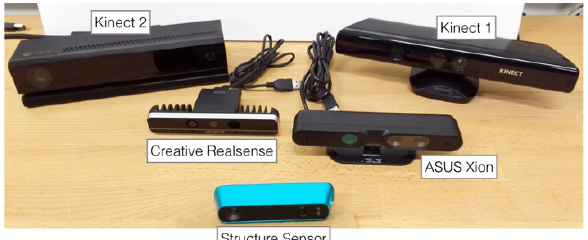
Figure 2. Devices characterized during the tests described in this